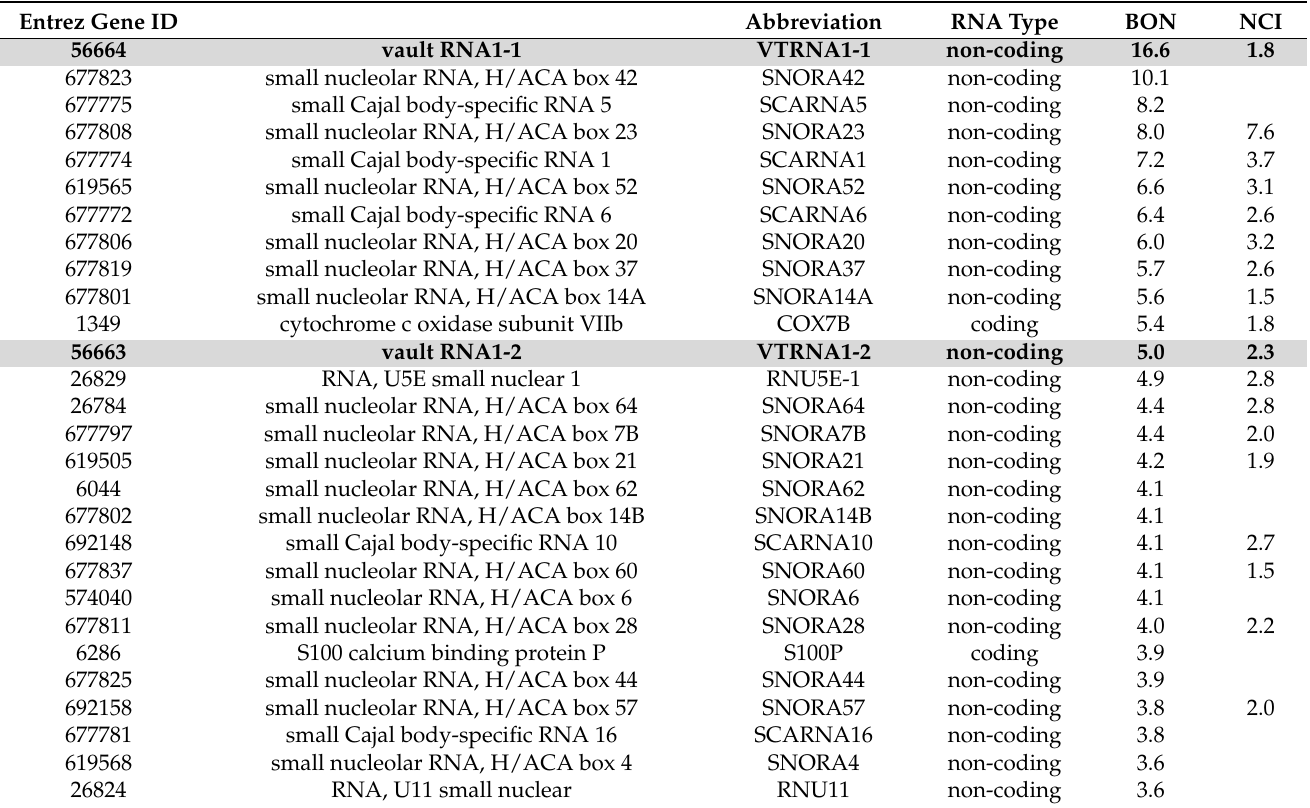
Table 1. Gene array analysis of NaCl- and ASA404-treated BON and NCI-H295R